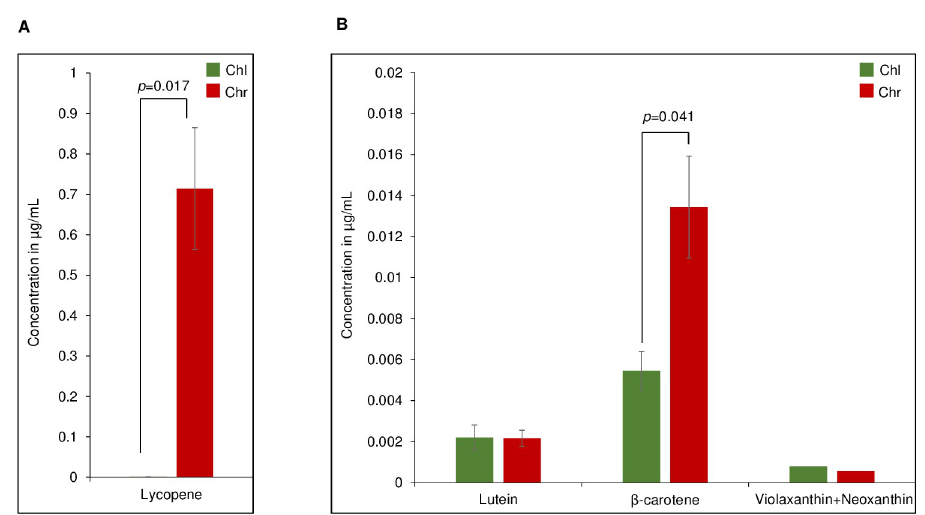
Fig 5. Lycopene and β -Carotene accumulate high levels in chromoplast PG. (A) Total carotenoids were extracted from equal volumes of gradient fractions containing chloroplast (Chl) or chromoplast (Chr) PG. Lycopene was quantified. (B) Quantification of lutein, β -carotene, and violaxanthin/neoxanthin. All values in the Fig are the mean of 3 biological replicates (n = 3). Statistical differences were assessed with students’ t test and p values are